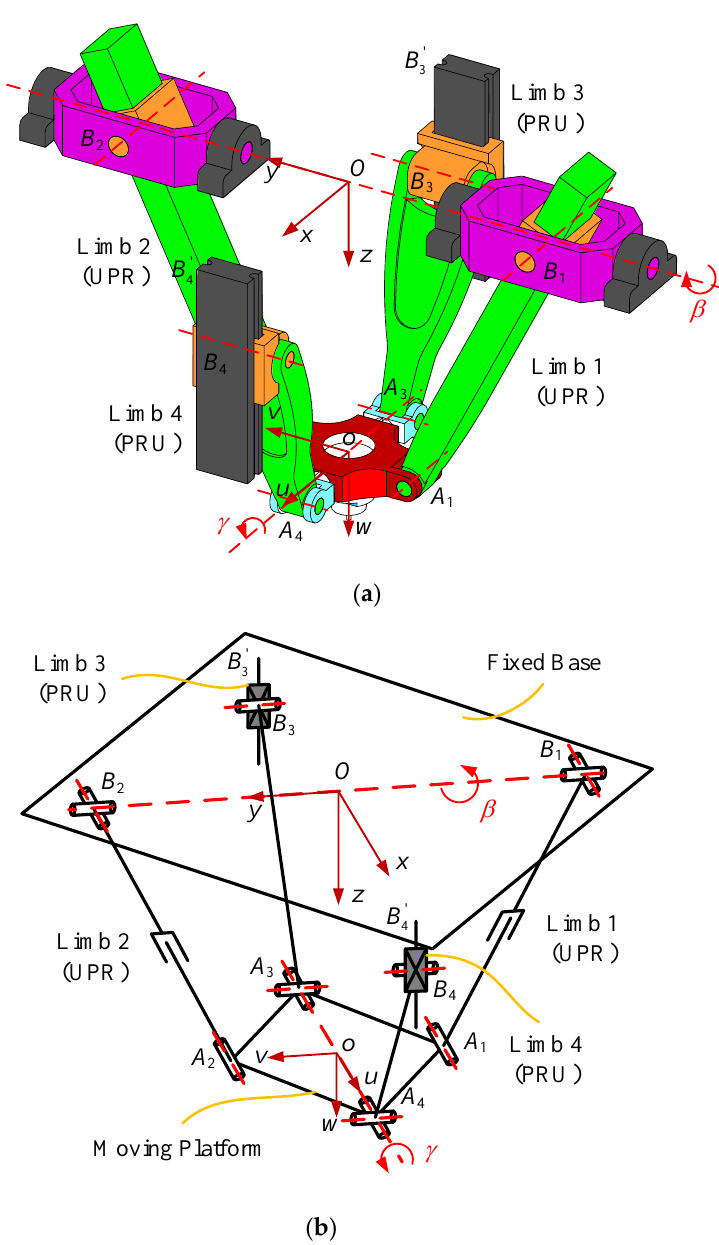
Figure 1. Three-dimensional model of the redundantly actuated 2UPR – 2PRU PM: ( a ) three-dimensional model; ( b ) schematic diagram.